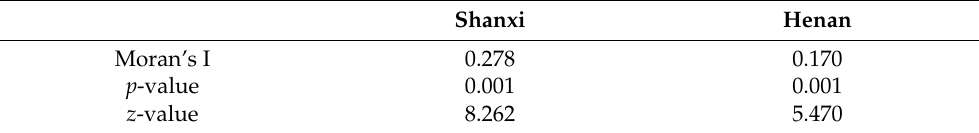
Table 2. Moran’s I value of internet attention for torrential rain in Shanxi and Henan. Shanxi Henan Moran’s I